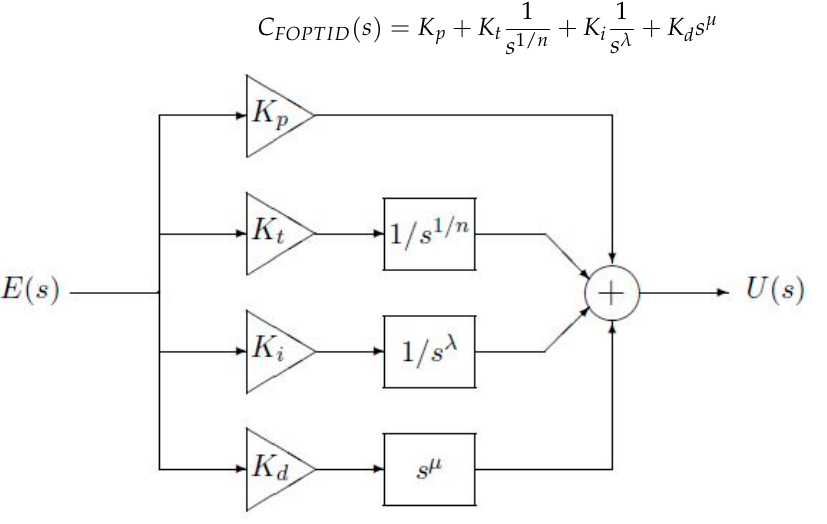
Figure 4. FOPTID controller structure.